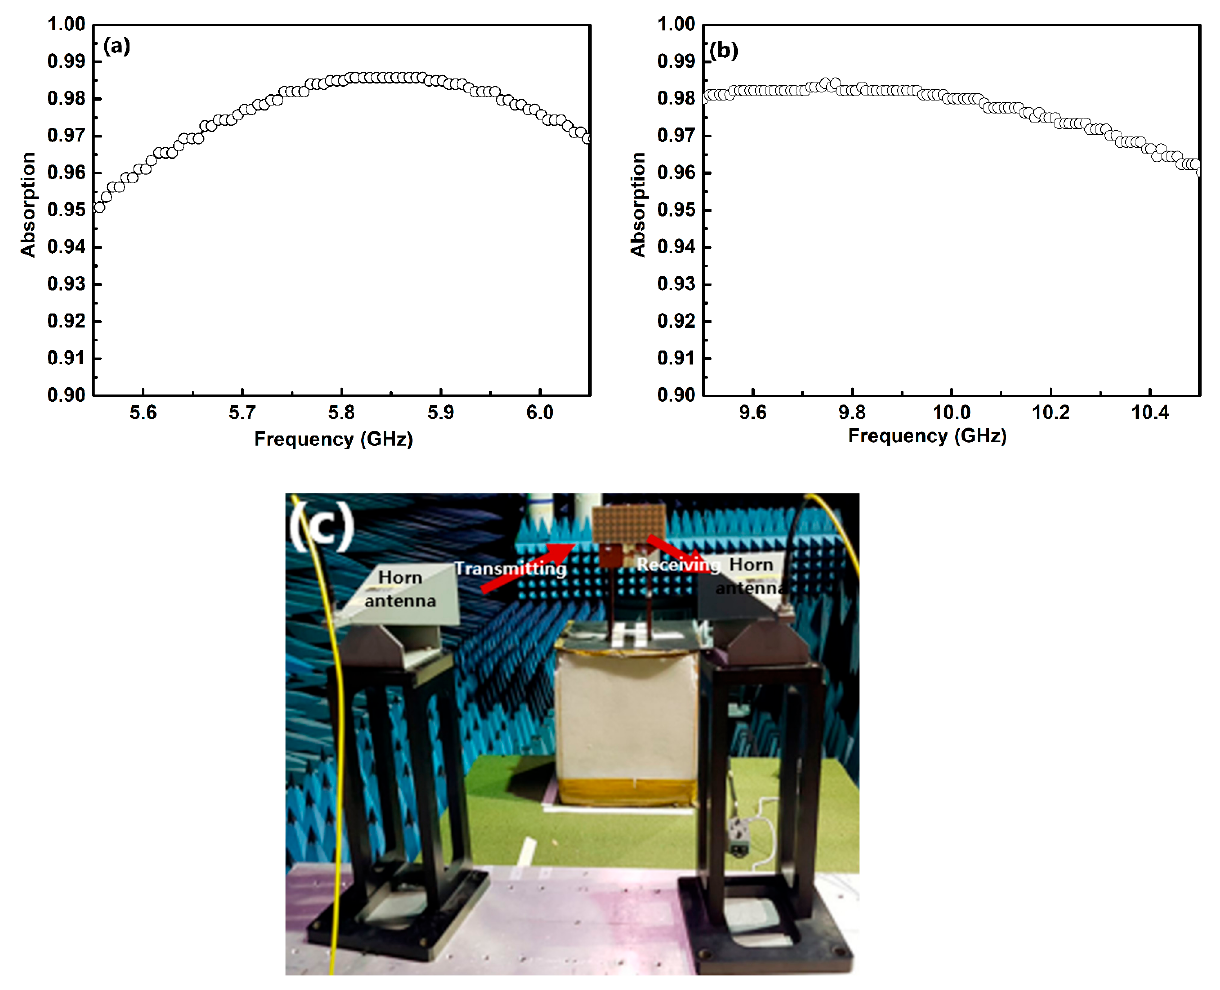
Figure 8. Absorption spectra of the MAs for ( a ) 5.8 and ( b ) 10 GHz. ( c ) Experimental setup.